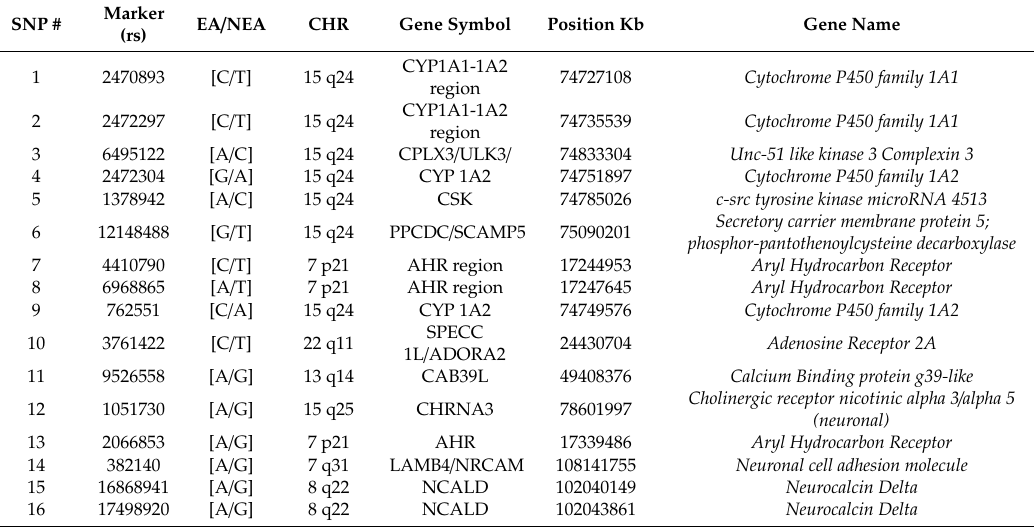
Table 1. Localization, gene names, and variant allele of all 16 SNPs